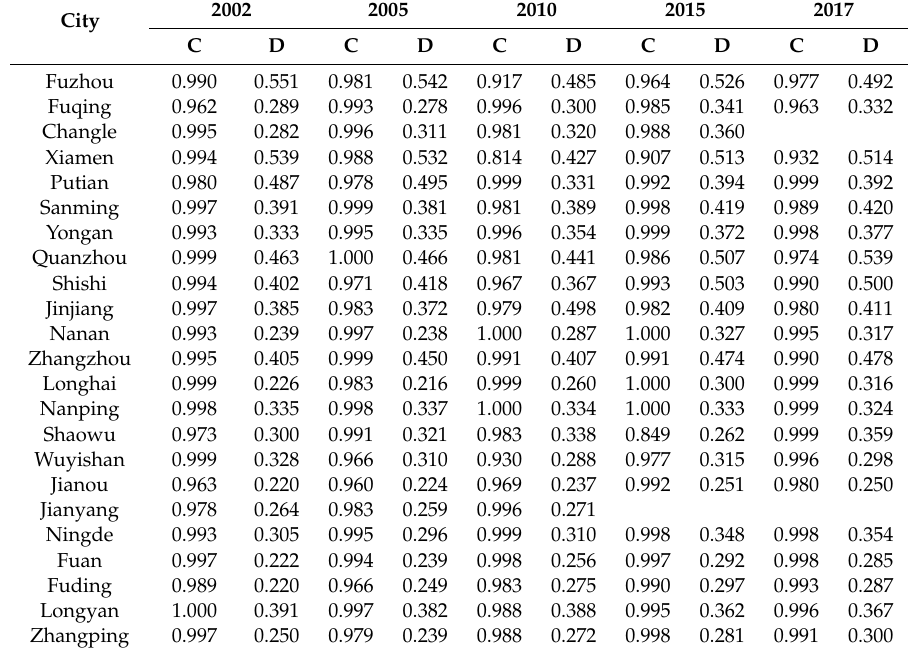
Figure 4. The spatial distribution diagram of the regional coupling coordination degree. ( a )—The spatial distribution diagram of coupling coordination degree in 2002.; ( b )—The spatial distribution diagram of coupling coordination degree in 2005. ( c )—The spatial distribution diagram of coupling coordination degree in 2010.; ( d )—The spatial distribution diagram of coupling coordination degree in 2015.; ( e )—The spatial distribution diagram of coupling coordination degree in 2017.; ( f )—The spatial distribution diagram of Variation type of coupling coordination degree. Table 5. Coupling coordination degree (CCD) of urban land use benefits and urbanization level in various